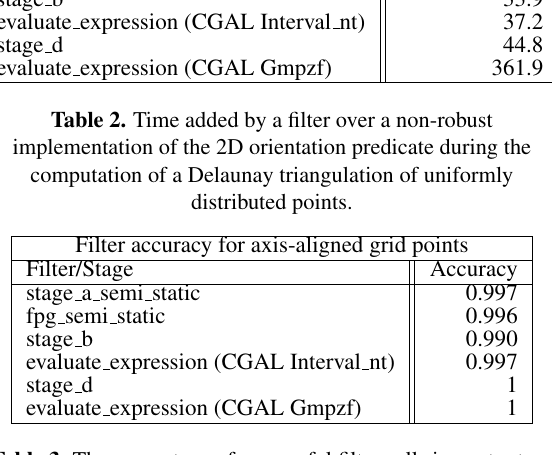
Table 3. The percentage of successful filter calls i.e. not return uncertain. Results obtained for the computation of the Delaunay Figure 2. Example code for the generation of a robust triangulation of points on an axis-aligned orientation predicate